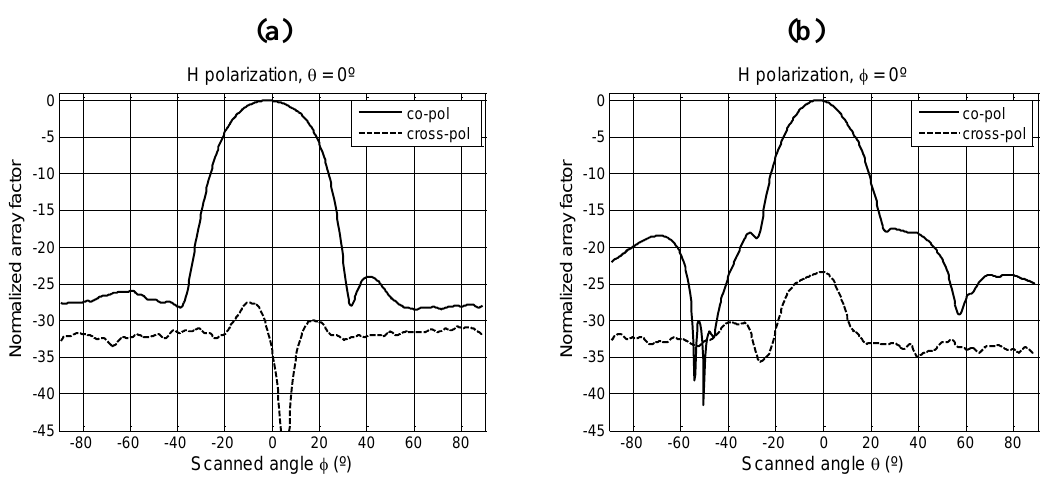
Figure 17. PAU-RAD DBF results in dB for the 0° steered beam and H polarization, (a) polar and cross-polar beams scanning on the φ domain (non-steerable), (b) polar and cross-polar beams scanning on the θ domain (steerable).